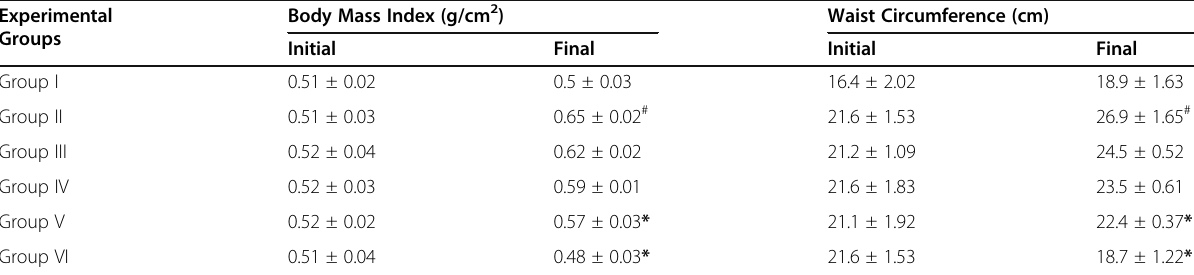
Table 2 BMI and Waist Circumference of Experimental Rats Experimental Groups